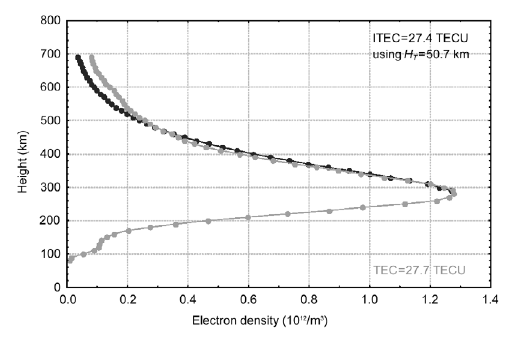
Fig. 9. Comparison between the ISR profile (gray line) and the extrapolated topside profile after the Huang and Reinisch (2001) method. The resulted to- tal electron content is also noted.